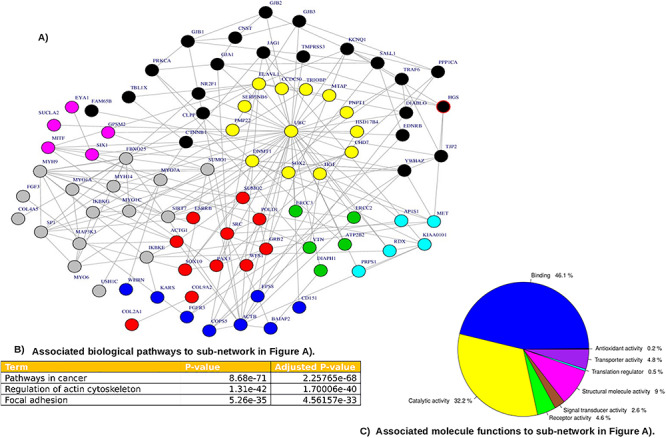
Community network analysis of the combined HI associated proteins (n = 159) and the population gene variant products (i.e. VTN, RPL3L, FOXD4L6 and DHRS4L2). The network in (A) indicates eight subnetworks, centered around UBC, with 10 hub proteins including UBC. The network is associated with regulation of the actin cytoskeleton and focal adhesion pathways (B) and with binding and catalytic activity molecular functions (C).